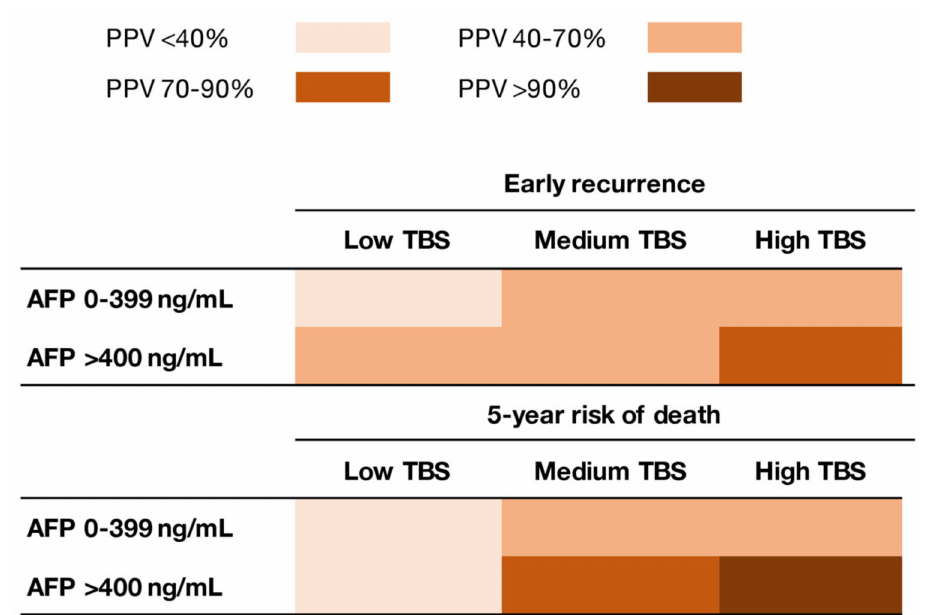
Figure 2. Heat map demonstrating differences in the positive predictive value (PPV) of TBS and AFP levels relative to early recurrence and 5-year mortality after resection for hepatocellular carcinoma (HCC).